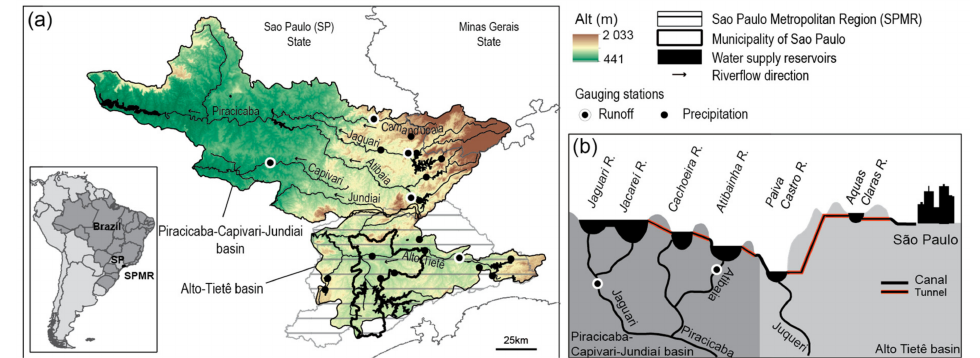
Figure 1. ( a ) Localization of S ã o Paulo metropolitan region (SPMR) and its main water supply reservoirs in the Alto-Tiet ê and Piracicaba-Capivari-Jundia í basins; ( b ) Simplified representation of the Cantareira system (R: